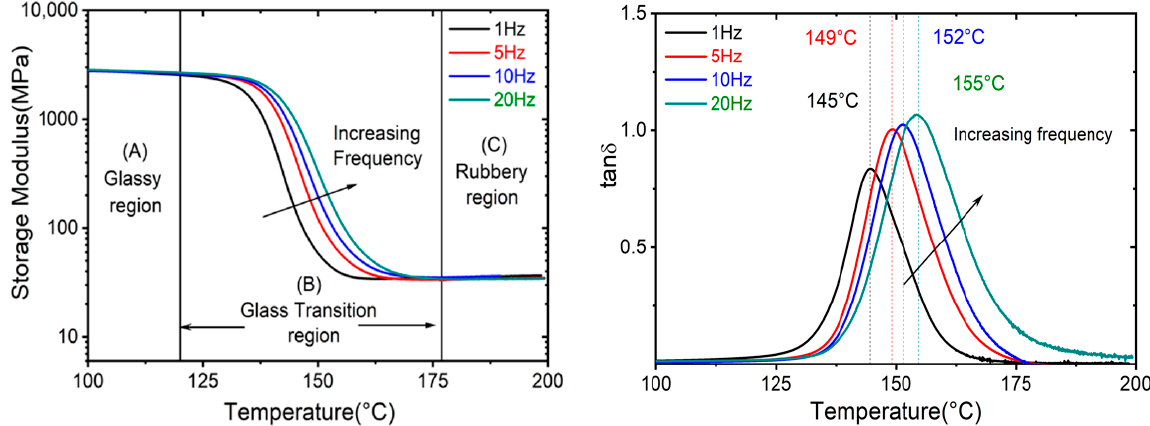
Figure 9. Effect of varying frequencies on the MEP system. Storage modulus vs. temperature curve ( left ) and tan δ vs. temperature ( right ).